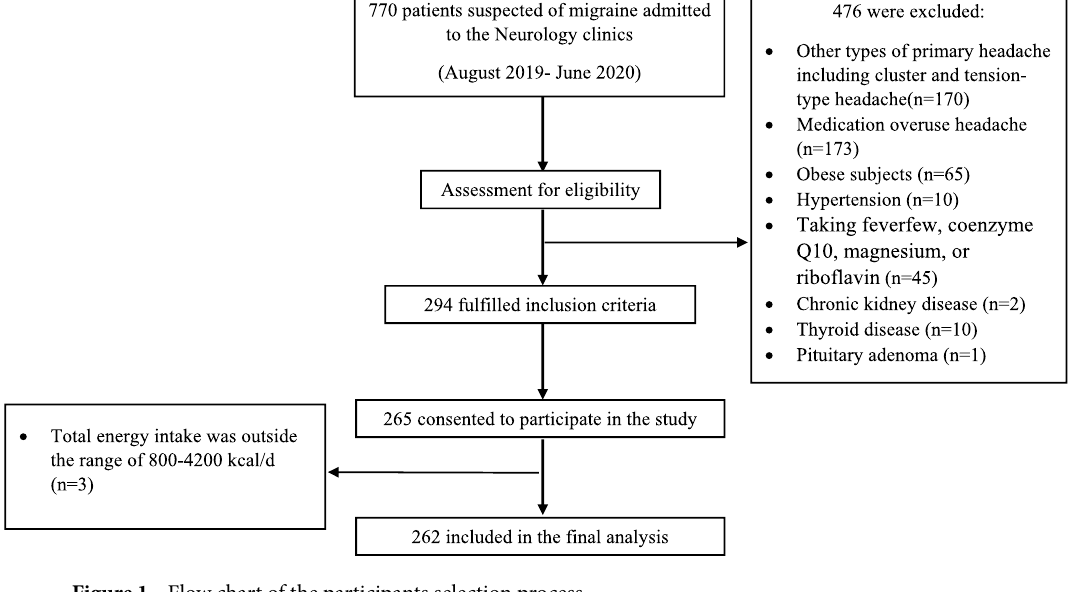
Figure 1. Flow chart of the participants selection